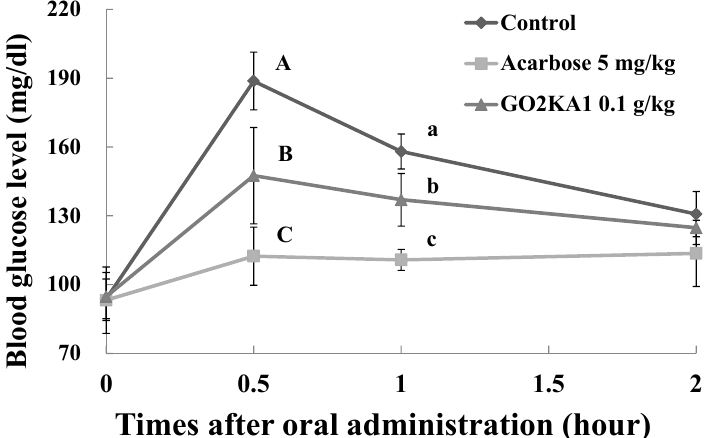
Figure 3. Effect of GO2KA1 on sucrose loading test. After fasting for 24 h, six-week-old, male SD rats were orally administered with sucrose solution (2.0 g/kg) with or without samples (GO2KA1; MW < 1000 Da, positive control; Acarbose). Each point represents mean ± S.D. ( n = 5). A − C Different corresponding letters indicate significant differences ( p < 0.05) at 0.5 h by Duncan’s test. a − c Different corresponding letters indicate significant differences ( p < 0.05) at 1.0 h by Duncan’s